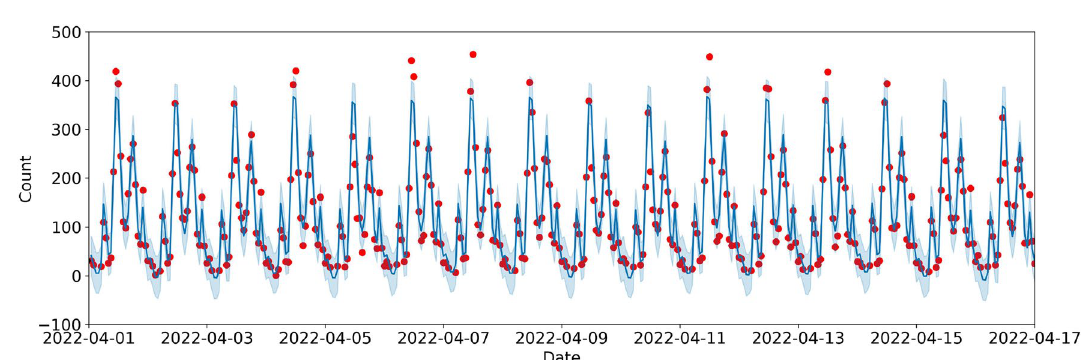
Figure 6. Forecast of the number of covers on an hourly basis for the period between April 01 and April 17, 2022 (inclusive). The blue line represents the forecast values, the light blue shade represents the 90% uncertainty interval for the counts, and the red dots represent the actual number of dining covers in a given